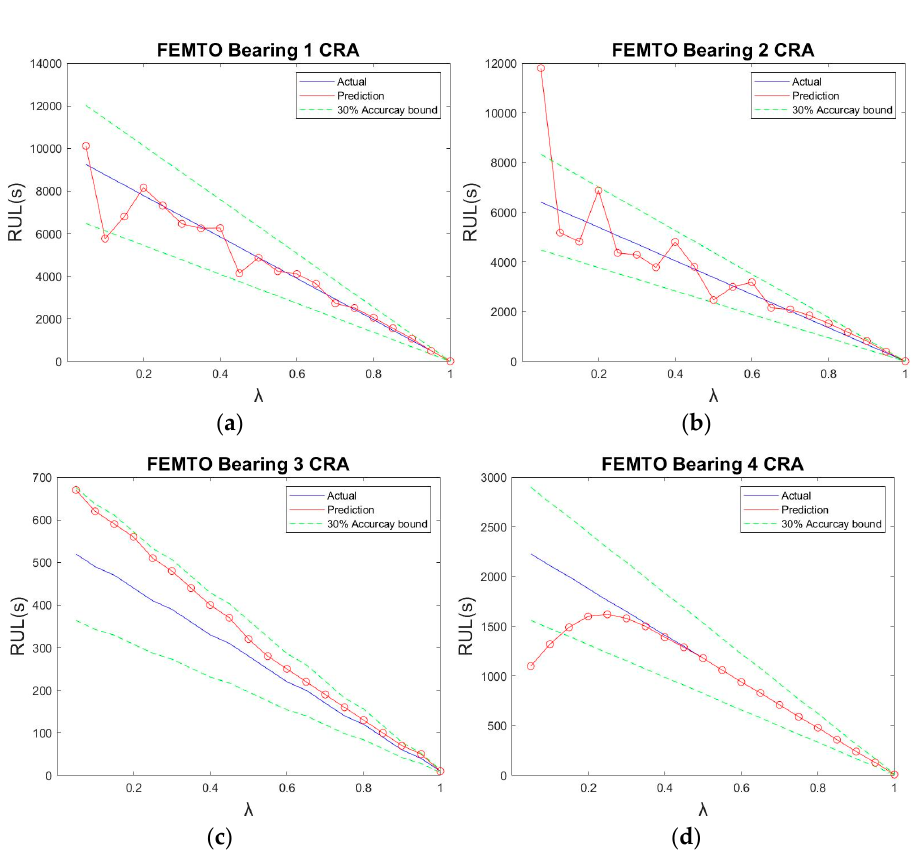
Figure 14. The CRA of the proposed method for the FEMTO-ST Test 1 database: ( a ) Bearing 1; ( b ) Bearing 2; ( c ) Bearing 3; and ( d ) Bearing 4.